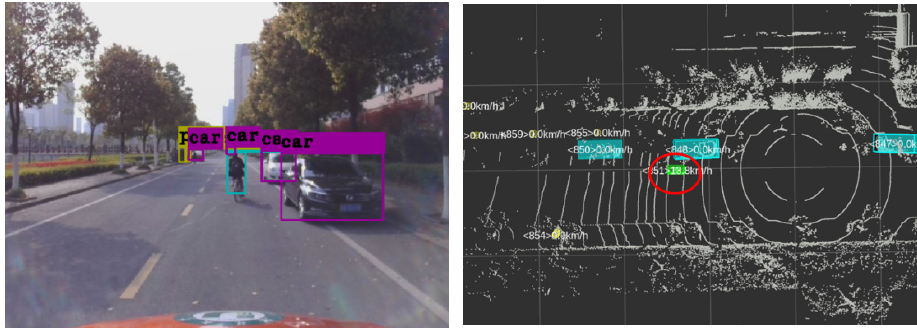
Figure 10. Visualized output of the mobile platform perception results.